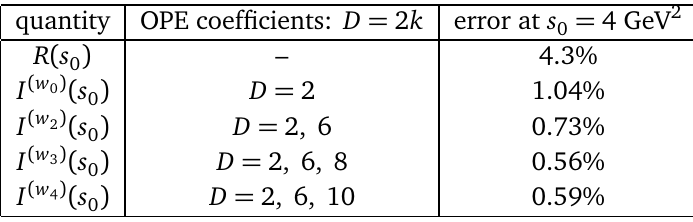
) of Eq. (5) evaluated for 0